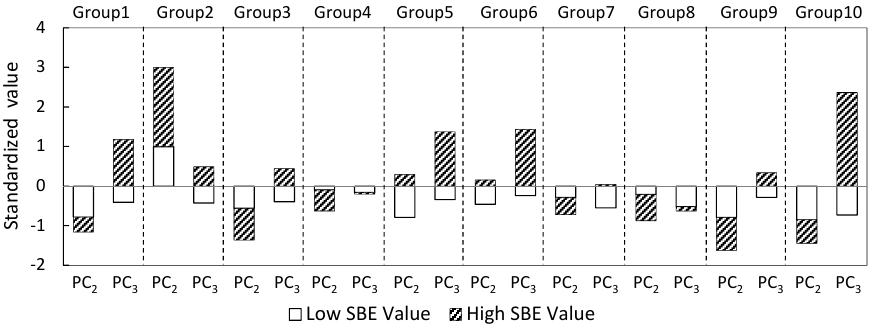
Figure 8. Variation tendencies between PC 2 , PC 3 , and the SBE values in Case 1.